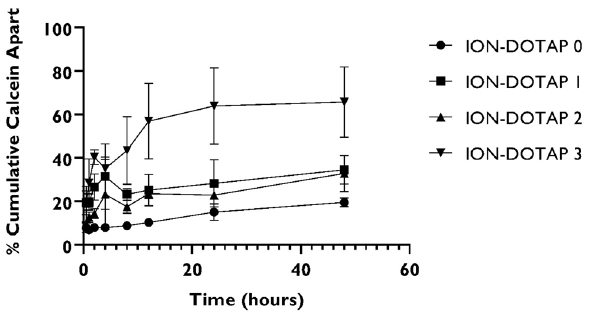
Figure 6. The calcein release profile of ION-DOTAP-0, ION-DOTAP-1, ION-DOTAP-2, and ION-DOTAP-3 liposomes in PBS pH 7.4 as the release media at a temperature of 37 °C.